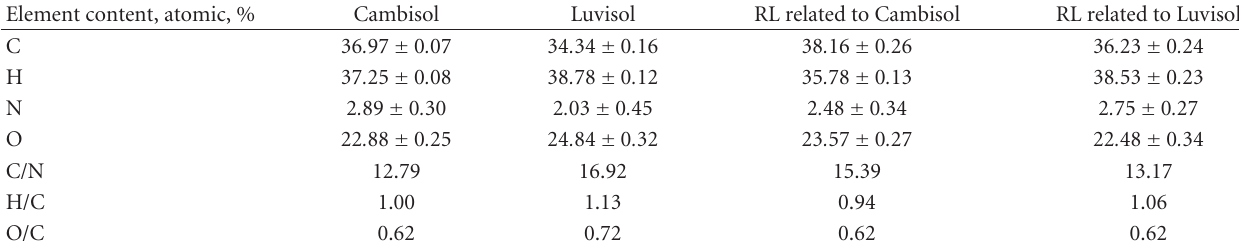
Table 3: HA elemental composition.